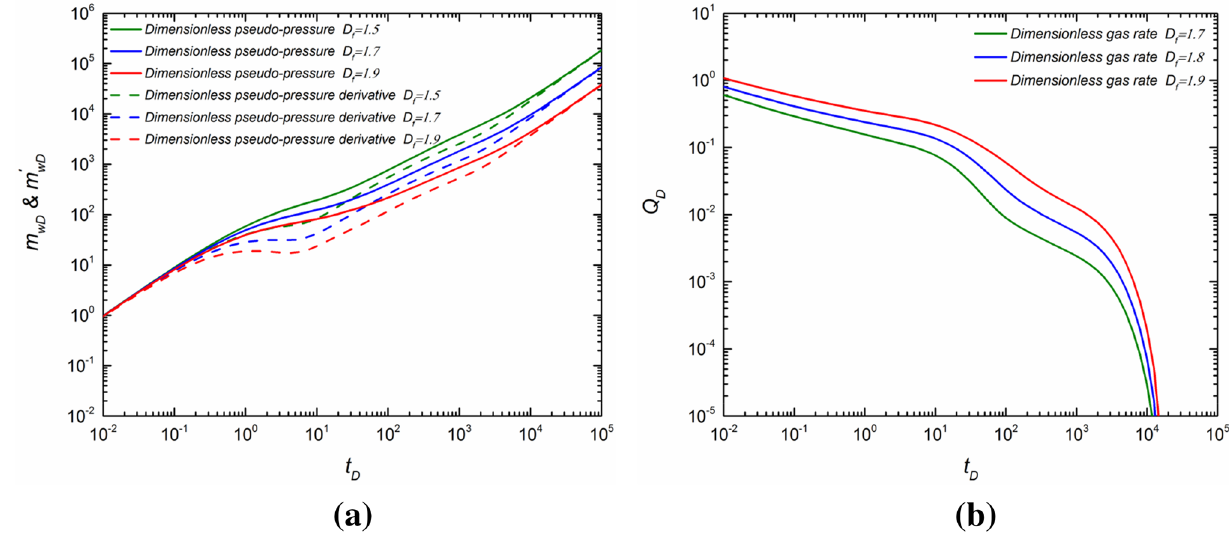
Fig. 8 Effect of fractal dimension on pseudo-pressure and rate curves. a Dimensionless pseudo-pressure and pseudo-pressure derivative curve, b dimensionless rate